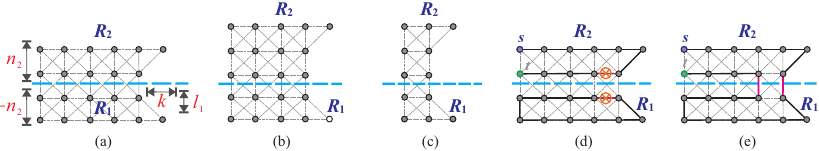
Figure 15. ( a – c ) A horizontal separation on C ( m , n ; k , l ; c , d ) for n > 3, ( d ) a Hamiltonian ( s , t ) -path in R 2 and a Hamiltonian cycle in R 1 , and ( e ) a Hamiltonian ( s , t ) -path in C ( m , n ; k , l ; c , d ) . Condition (F4) holds, if a = 2, n 2 > 2, s x , t x (cid:54) 2, s y , t y (cid:54) 2, s x (cid:54) = t x , and s y (cid:54) = t y .